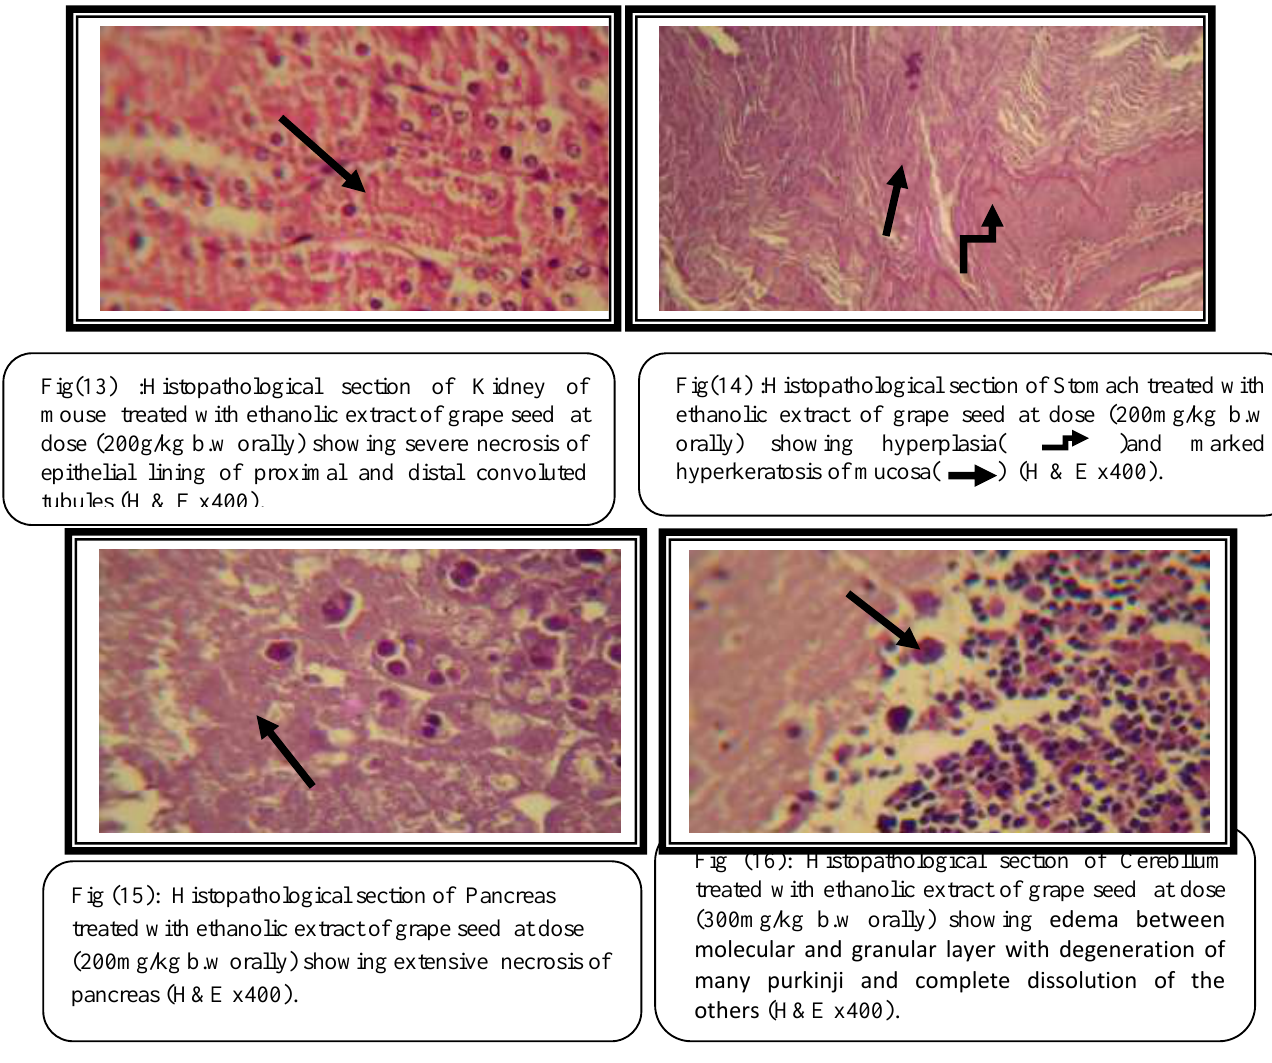
Fig (15): Histopathological section of Pancreas treated with ethanolic extract of grape seed at dose (200mg/kg b.w orally) showing extensive necrosis of pancreas (H&E x400).